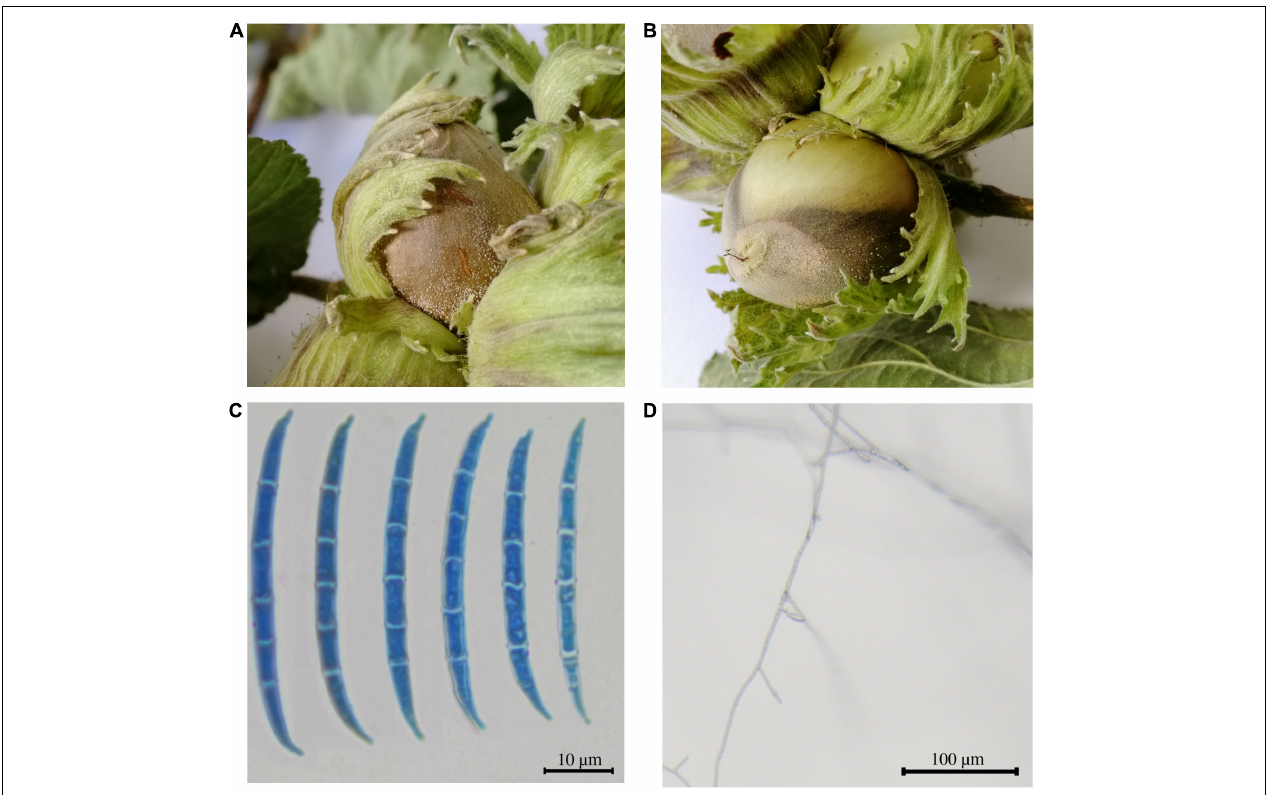
FIGURE 1 | Symptomatic hazelnuts and microscopic characteristics of the Fusarium sp. isolate PT. (A,B) The symptomatic fruits were characterized by a brown grayish necrotic spot/patch on the nut shell, bracts and less often on the petioles. (C) Macroconidia and (D) monophiliades of the isolated fungus visualized through optical